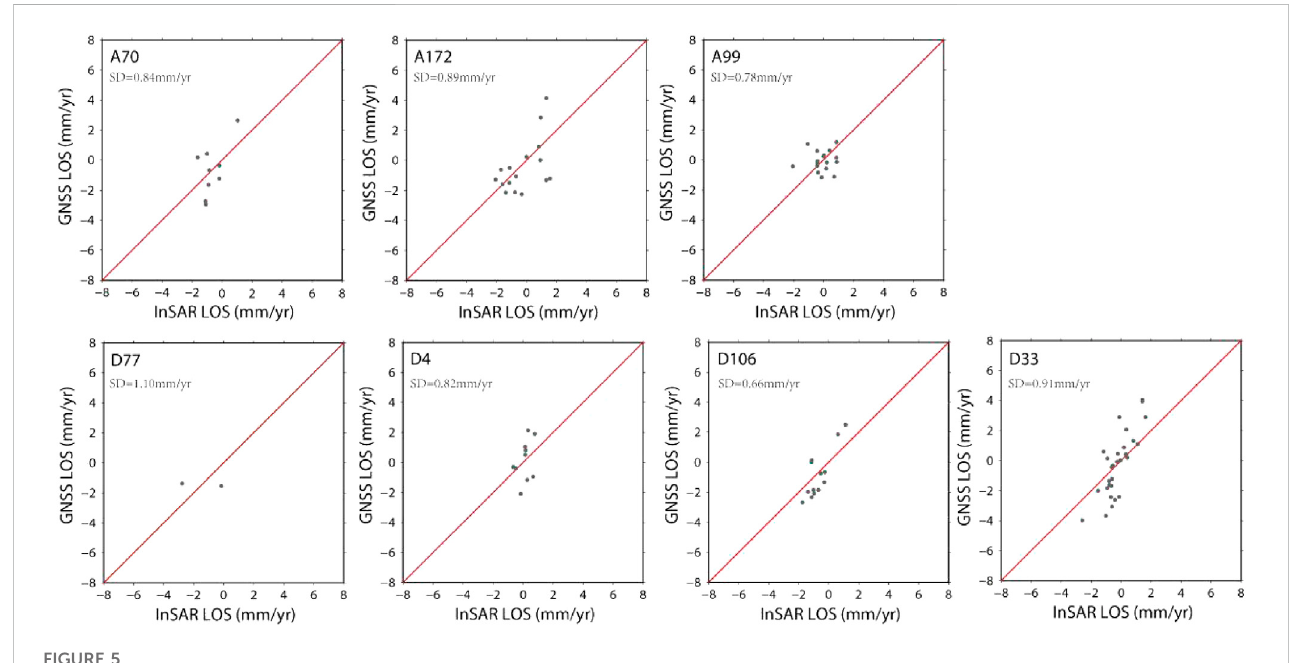
FIGURE 5 Scatter plots of InSAR and GNSS LOS